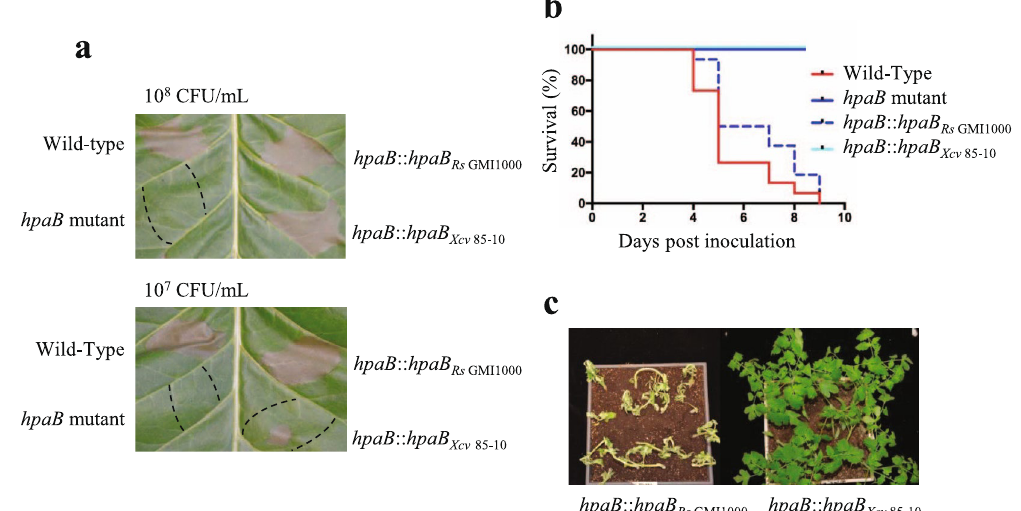
Figure 5. The hpaB gene from X . campestris pv. vesicatoria ( Xcv ) 85–10 can complement the R . solanacearum hpaB mutant to trigger an hypersensitive response (HR) on tobacco plants, but not for disease establishment on tomato plants. ( a ) N . tabacum leaves were infiltrated with R . solanacearum bacterial suspensions at 10 8 CFU/ ml (upper part) and 10 7 CFU/ml (lower part), using the GMI1000 wild-type strain, the hpaB mutant (GMI1000 background), the hpaB mutant complemented with the hpaB gene from R . solanacearum GMI1000 and the hpaB mutant complemented with the hpaB gene from Xcv 85-10 . Pictures were taken 24 h post infiltration. The dotted lines represent the infiltrated areas. Experiments were repeated three times with similar results. ( b ) Kaplan-Meier survival analysis of 16 tomato plants per R . solanacearum strain root inoculated. Gehan-Breslow- Wilcoxon test indicates that the wild-type strain curve (red) is significantly different from the hpaB mutant curve (blue) (p-value < 0.001), and to the curve showing the hpaB mutant complemented with the Xcv 85-10 hpaB gene (p-value < 0.001). The wild-type strain curve (red) is not significantly different from the curve showing the hpaB mutant complemented with R . solanacearum GMI1000 hpaB gene (dotted cyan) (p-value = 0.0678). Three biological repeats were performed with similar results. ( c ) Representative pictures showing the tomato responses six days after inoculation of the R . solanacearum hpaB mutant complemented with the hpaB genes isolated from R . solanacearum GMI1000 (left) or Xcv 85-10 (right). Experiments were repeated three times with similar